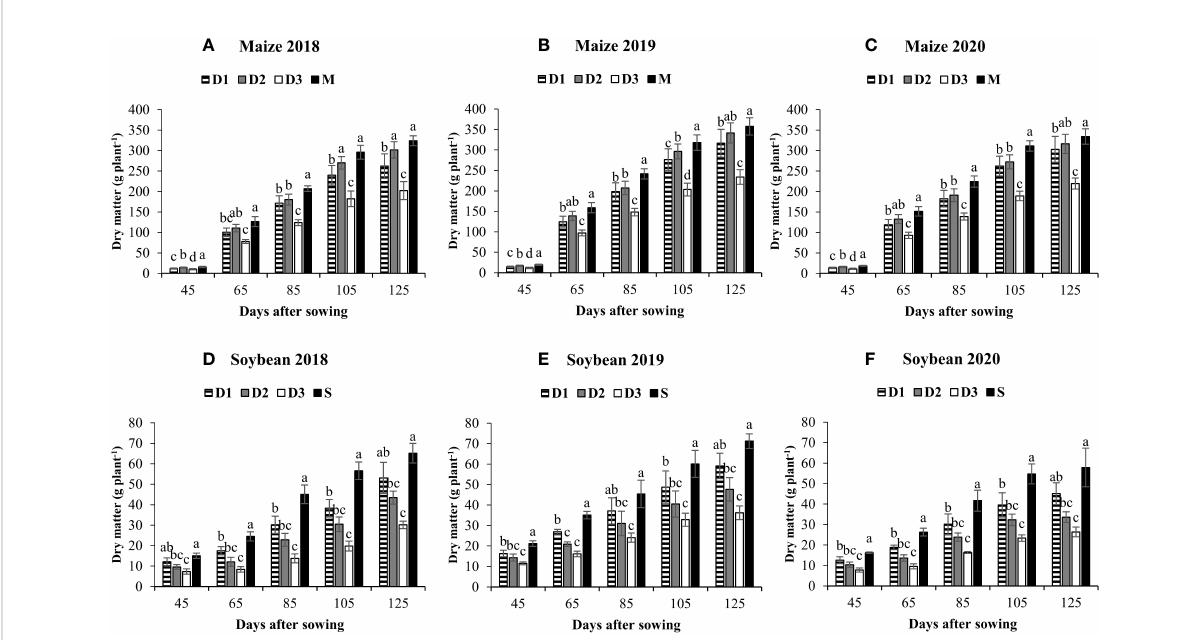
FIGURE 4 Dry matter of maize (A – C) and soybean (D – F) in response to different maize planting densities (6 maize plants m -2 , low, D 1 ; 8 maize plants m -2 , medium, D 2 ; and 10 maize plants m -2 , high, D 3 ) under maize/soybean strip intercropping. Bars show ± standard errors (n = 3). The different lowercase letters within a bar show a signi fi cant difference (p < 0.05) among treatments. The M and S represent the sole maize and soybean,